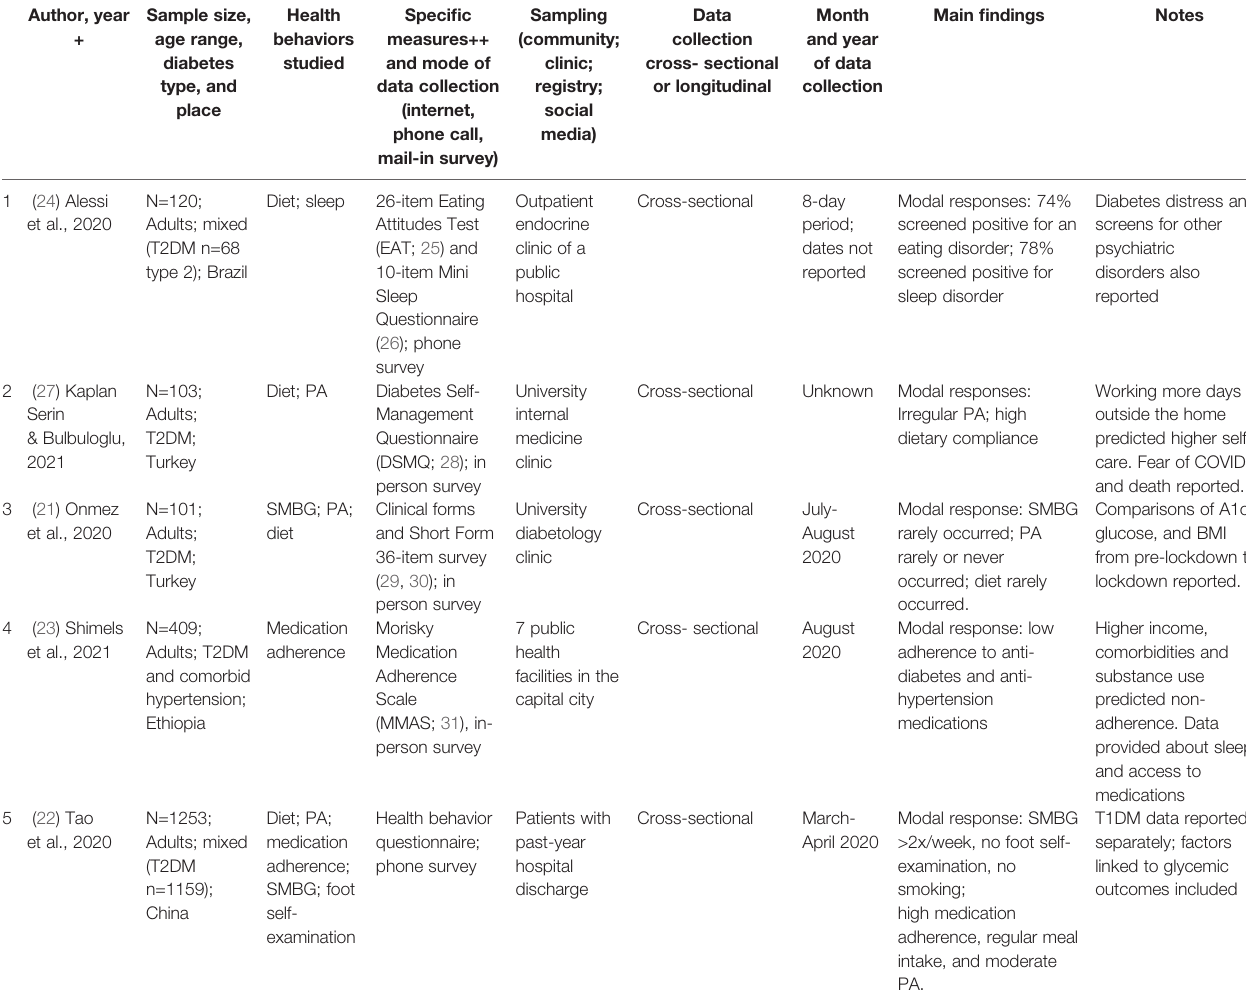
TABLE 1 | Frequency of health behaviors among people with type 2 diabetes during COVID